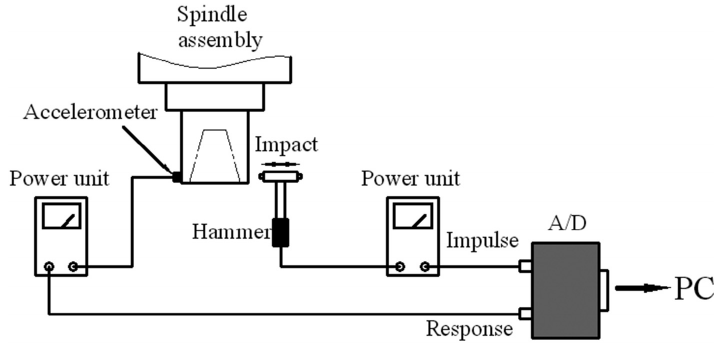
Fig. 4. Impacting test scheme of the spindle assembly.